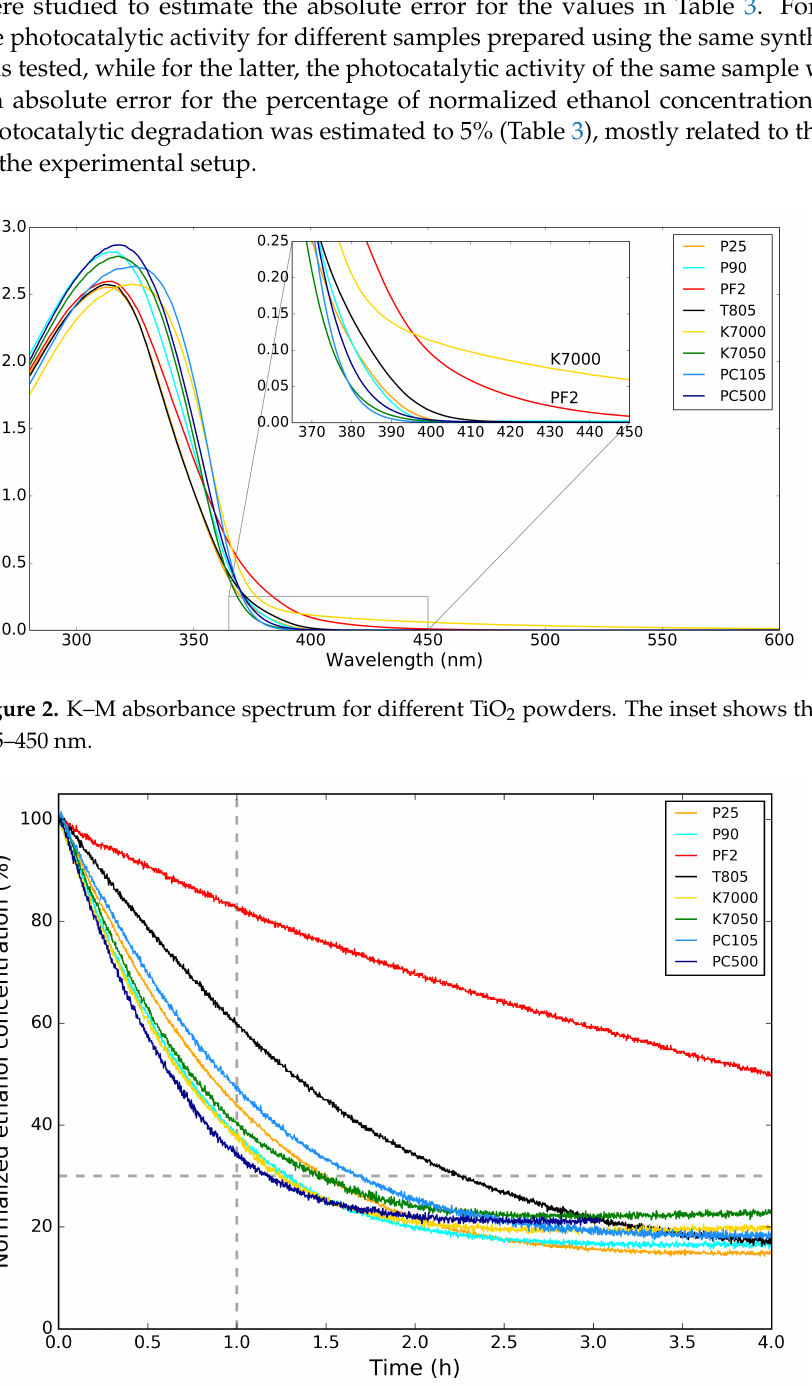
Figure 3. Photocatalytic degradation of ethanol for the TiO 2 powders measured at m / z = 45 amu. Only the part of the graph above the dashed line is considered for greater accuracy, since it is an artifact of the correction (see